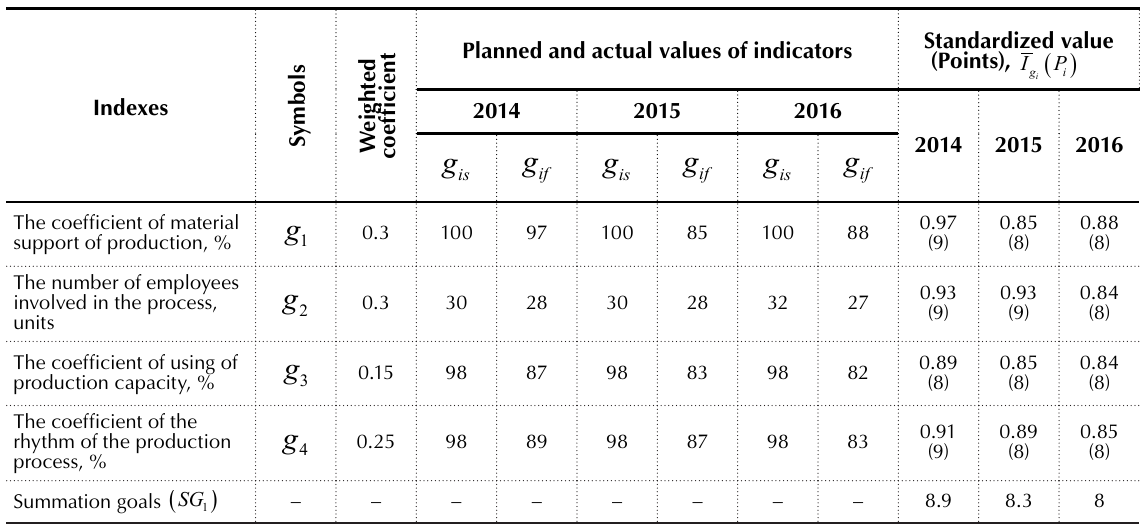
Source: calculated by